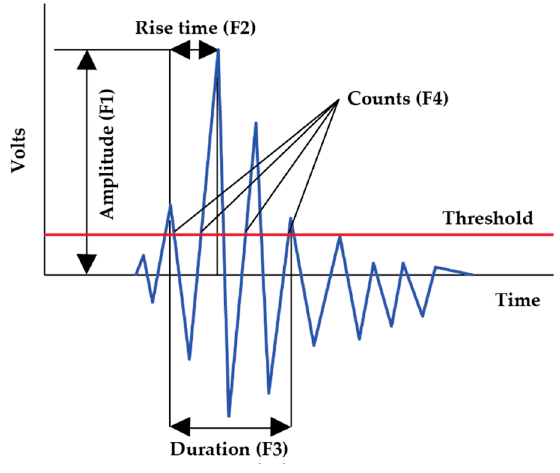
Figure 6. Considered AE signal features.